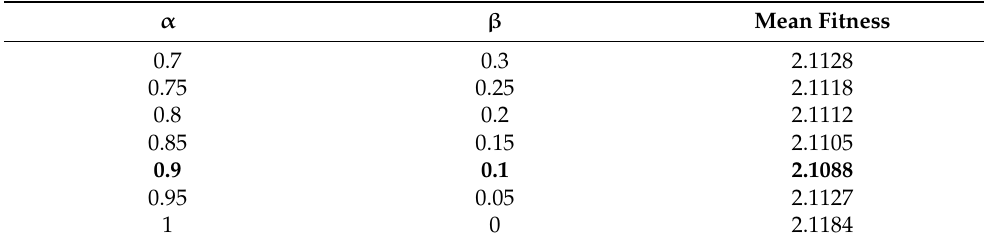
Table 1. Tuning the smoothing parameters of CE-CMAES.